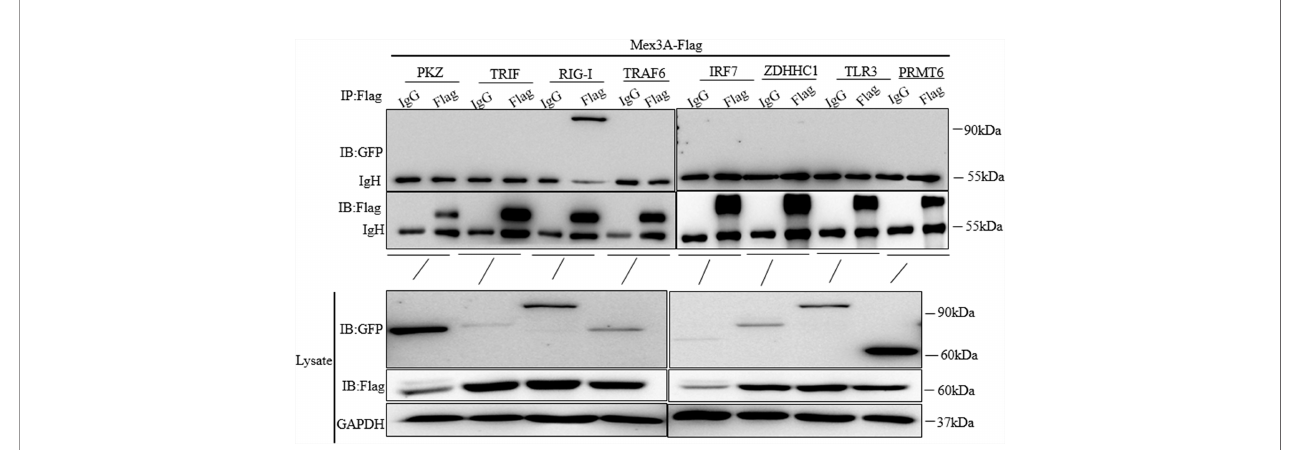
FIGURE 3 | Grass carp Mex3A interacts with RIG-I. CO cells were individually co-transfected with Mex3A-Flag plasmids and PKZ-GFP, TRIF-GFP, RIG-I-GFP, TRAF6-GFP, IRF7-GFP, ZDHHC1-GFP, TLR3-GFP, and PRMT6-GFP. Western blotting was used to analyze all the immunoprecipitation samples. The results are representative of three independent